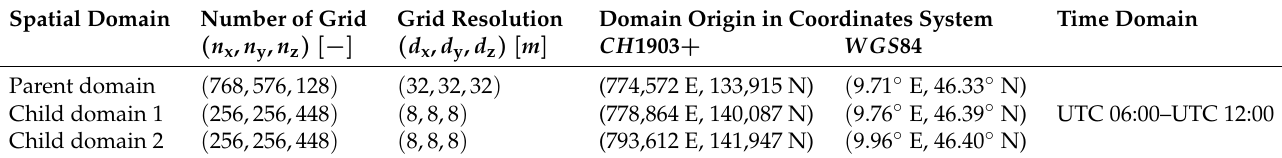
Table 2. Computational domain